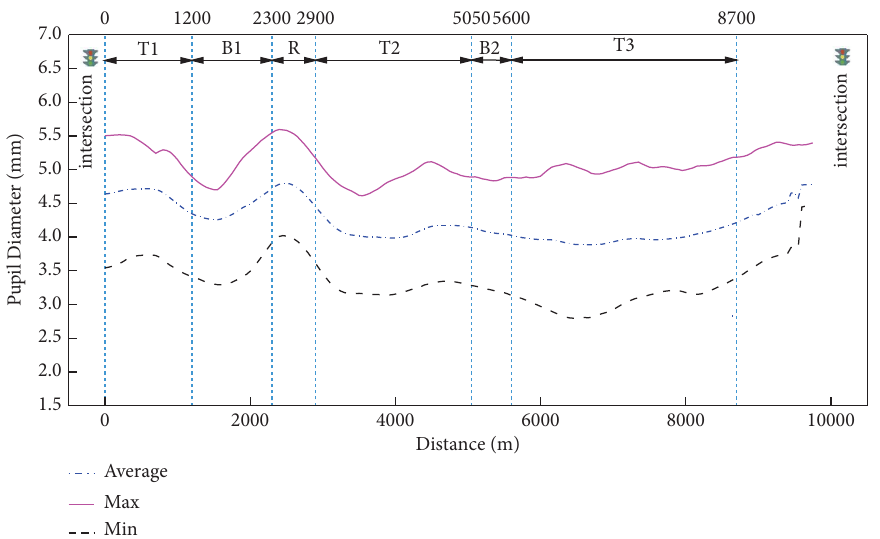
Figure 5: Te pupil diameter varies with distance at